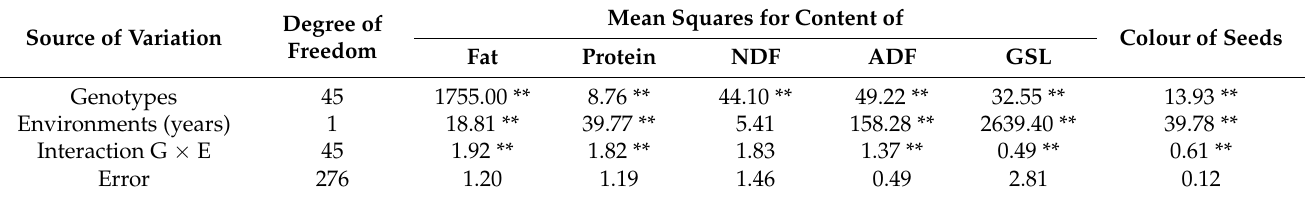
Table 2. Two-factor analysis of variance of genotypes (DH lines and parents) and environments (years) for six traits of